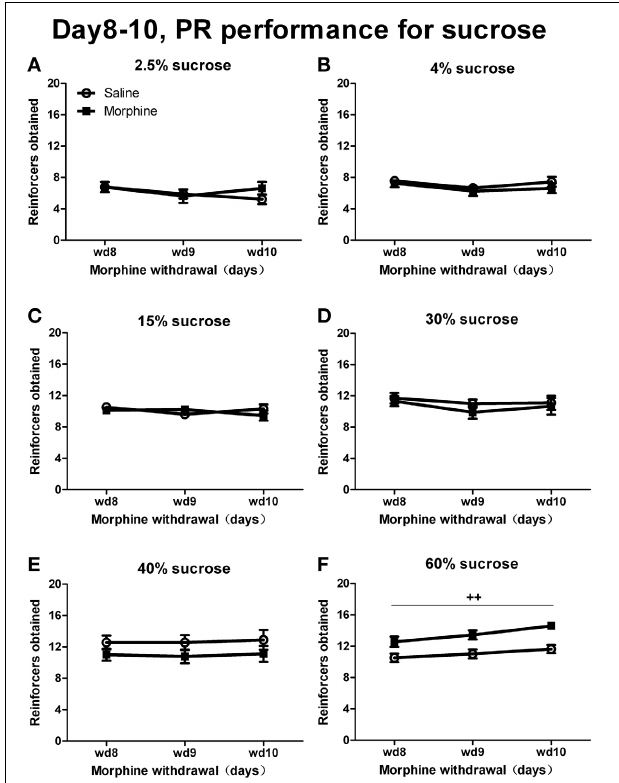
FIGURE 6 | Number of reinforcers obtained under a PR schedule of reinforcement on day 8–10 of withdrawal. Rats were reinforced by sucrose solutions with different concentrations of 2.5% (A) , 4% (B) , 15% (C) , 30% (D) , 40% (E) , or 60% (F) . ++ P < 0 . 01, a significant main effect of pretreatment. Values are mean ±